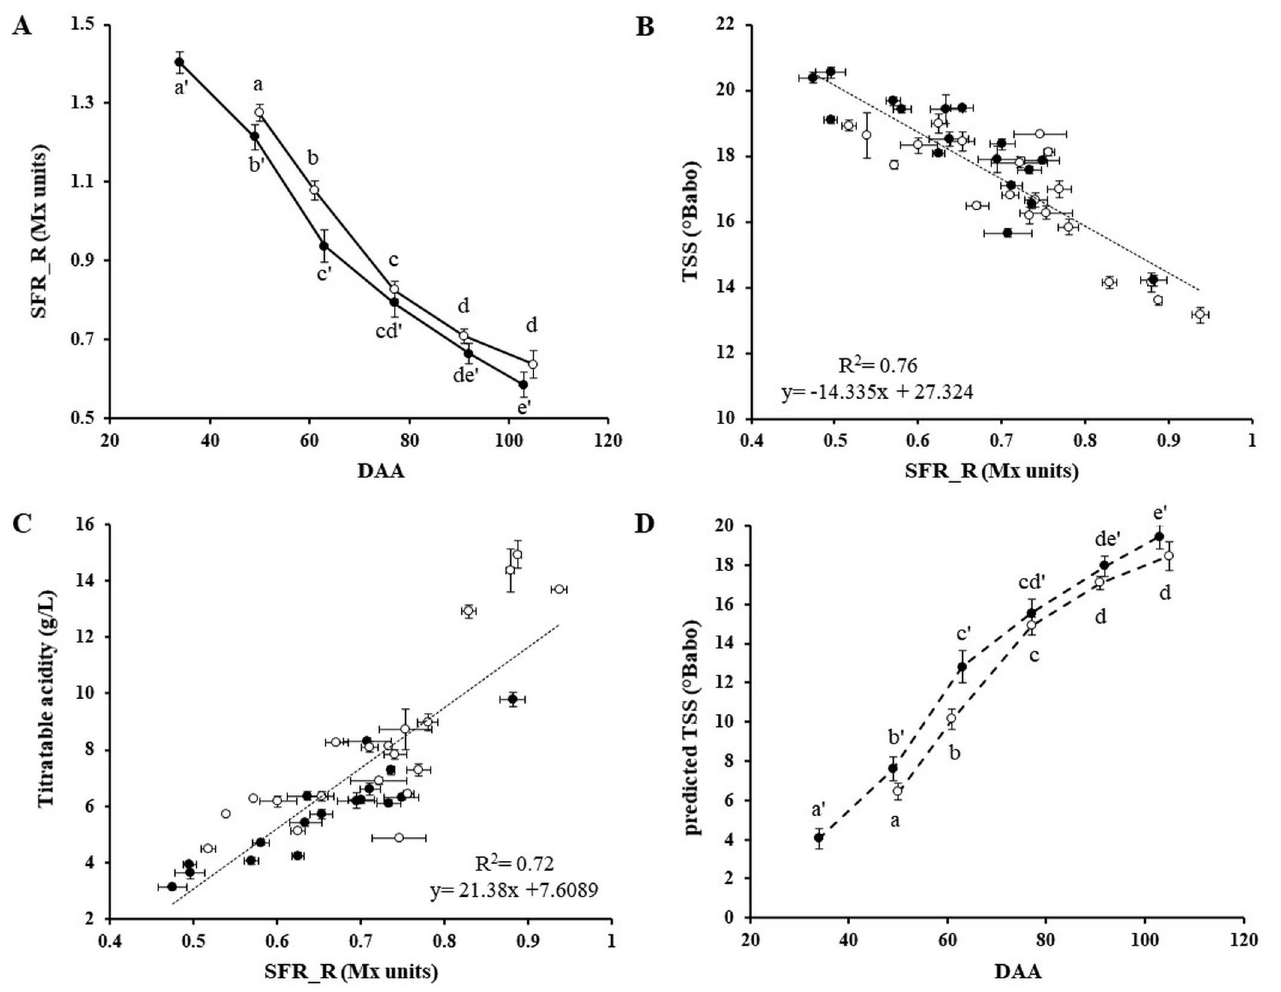
Fig 2. SRF_R index, berry skin chlorophyll content and grape maturity parameters. Evolution of SFR_R index (A) and predicted TSS (D) over Day After Anthesis (DAA) for 2017 ( � ) and 2018 (•), respectively. Each point represents the mean ± standard errors calculated over the plots under investigation over 6 and 5 time-points during the two vintages. Different letters indicate significant differences according to Tukey’s test ( α = 0.05). Correlation between SFR_R (Mx units) and Total Soluble Solids (TSS, ˚Babo) (B), and between SFR_R and Titratable acidity (g/L) (C). Trend lines, R 2 coefficient and linear equations are reported in the graphs. Each point represents the average value of three replicates for each variable recorded in 2017 ( � ) and 2018 (•), respectively. Standard errors of each variable are displayed according to the specific axis